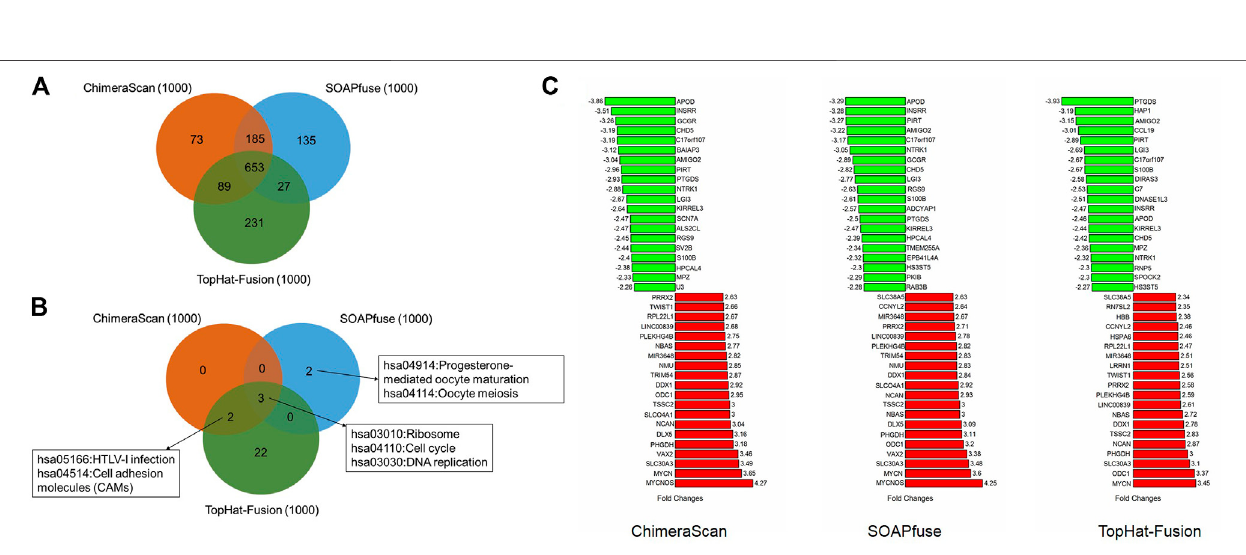
Frontiers in Pharmacology |